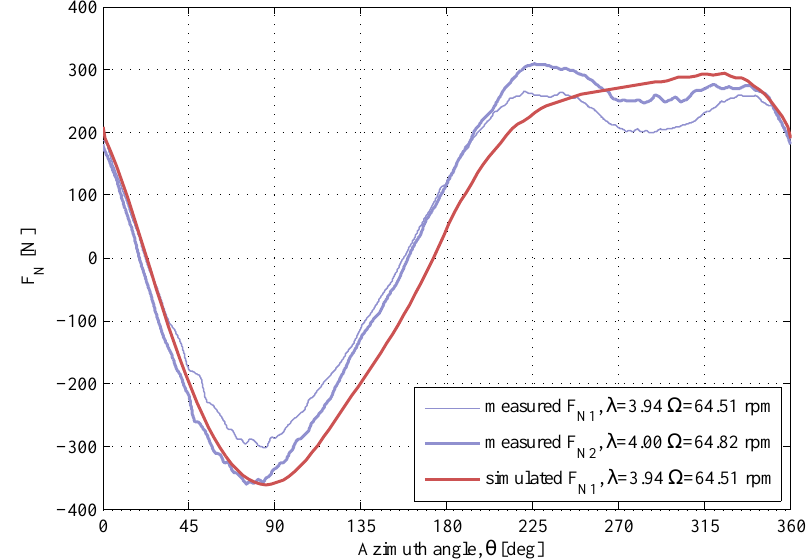
Figure 16. The normal forces for two different sets of data with almost identical λ and Ω . The air densities and the kinematic viscosities are ρ ν = 1 . 44 · 10 − 5 m 2 / s , ν 1